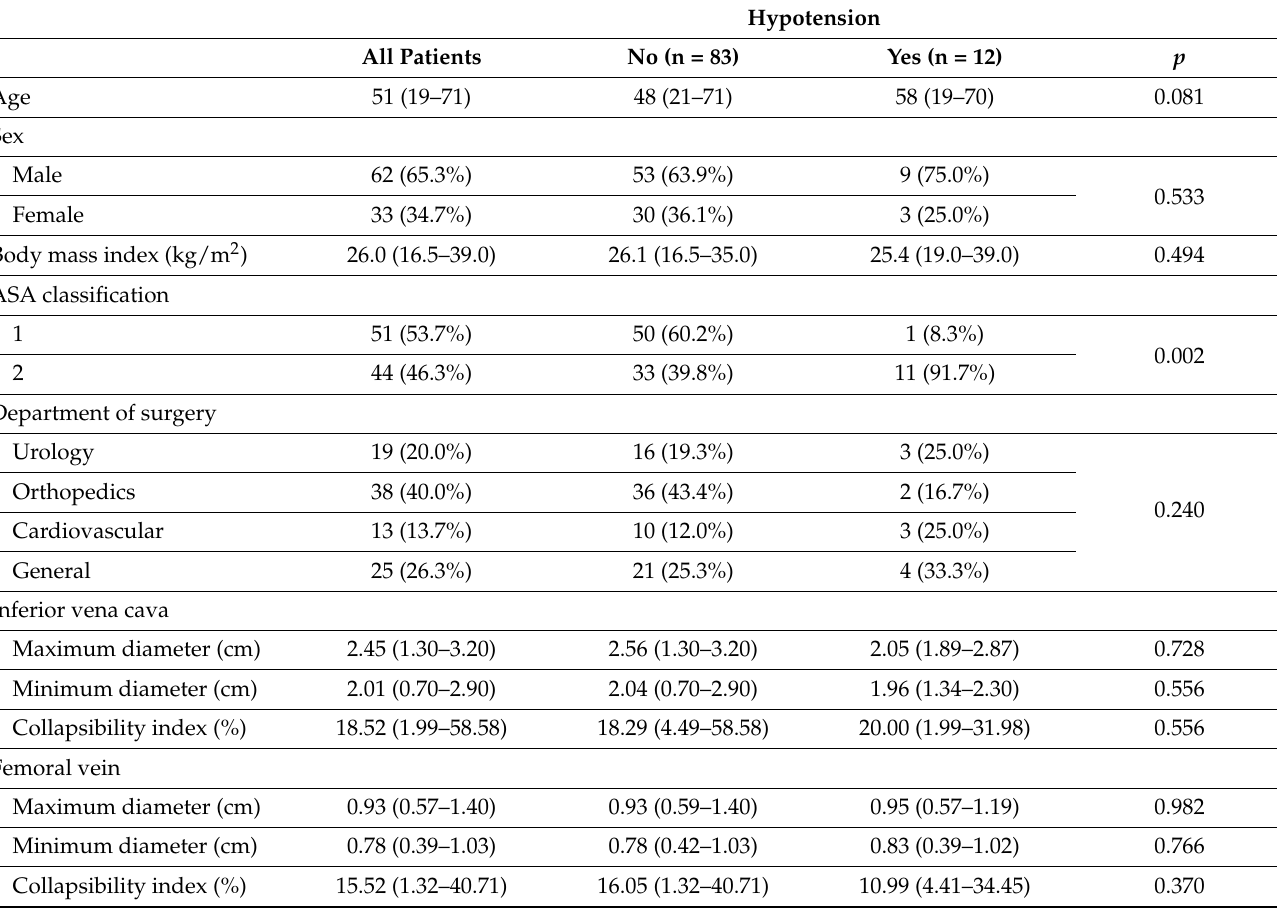
Table 1. Summary of patient characteristics and their relationship with